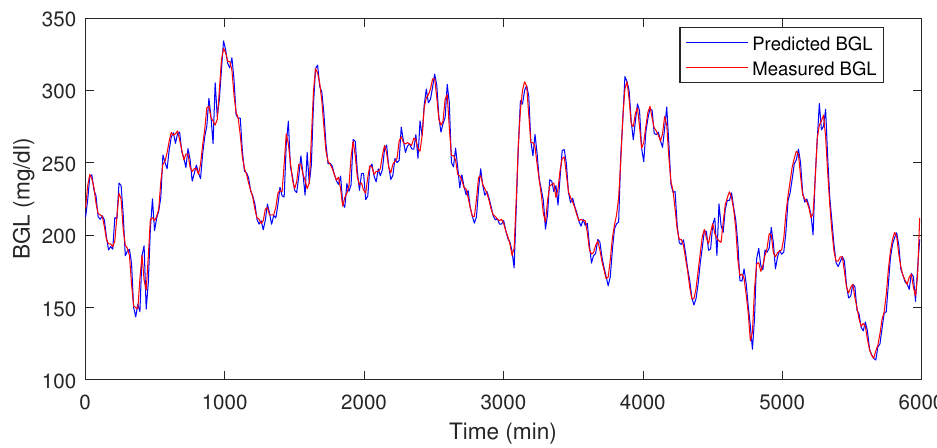
Figure 9. LSTM prediction result for